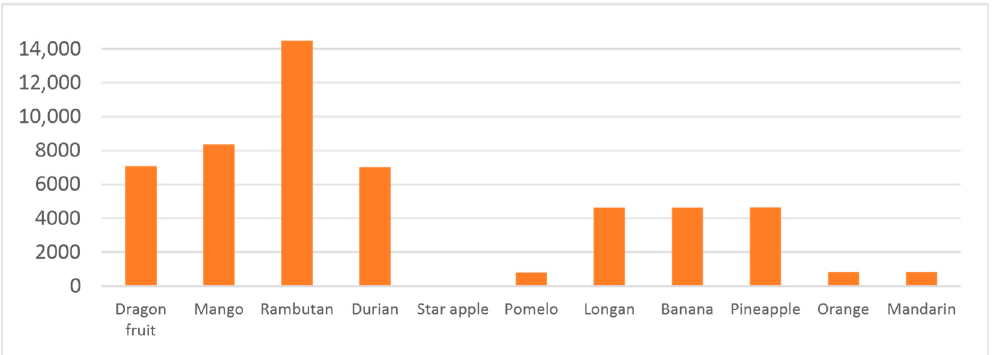
Figure 9. Early and delay time in transportation of fruits (hour).